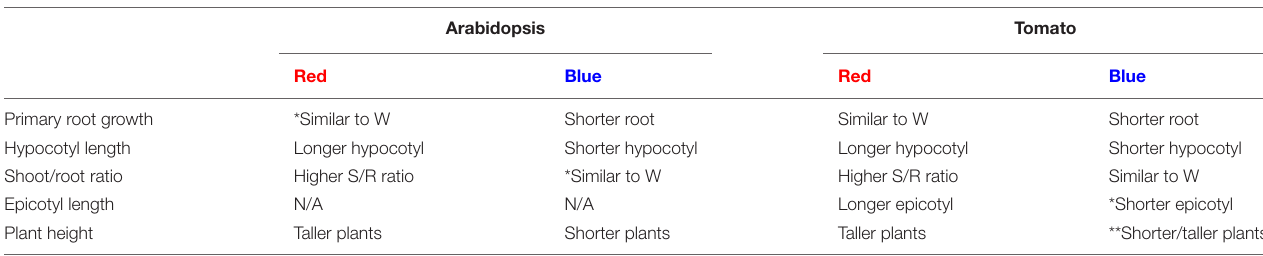
TABLE 1 | Primary growth of Arabidopsis and tomato is regulated by red and blue light.